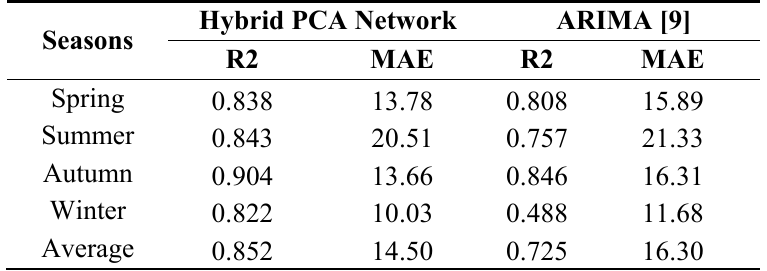
Table 11. Comparison between the proposed hybrid PCA and ARIMA [9] (Fisk).